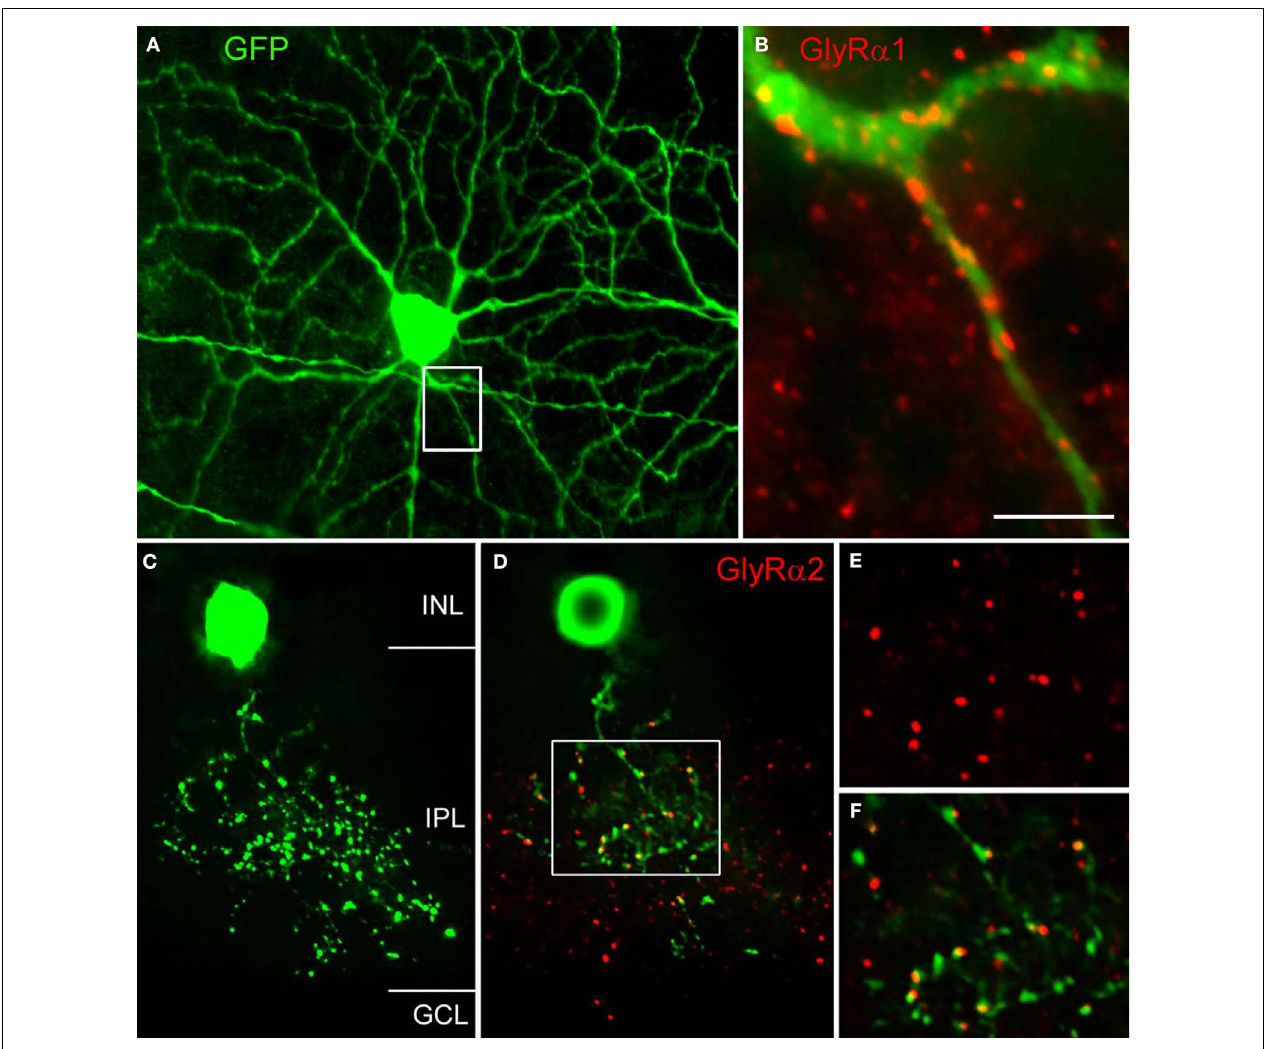
FIGURE 5 | Expression of GlyRs by identifi ed neurons (modifi ed from Majumdar et al., 2007) . (A) This A-type ganglion cell expressed EGFP in a whole mount of the thy1 GFP-O mouse (Feng et al., 2000). The whole mount was also immunostained for GlyR α 1. (B) The boxed area from (A) is shown at higher magnifi cation and the dendrite of the A-type ganglion cell is decorated by GlyR α 1 immunoreactive puncta. (C) Vertical view of a Type 3 amacrine cell from